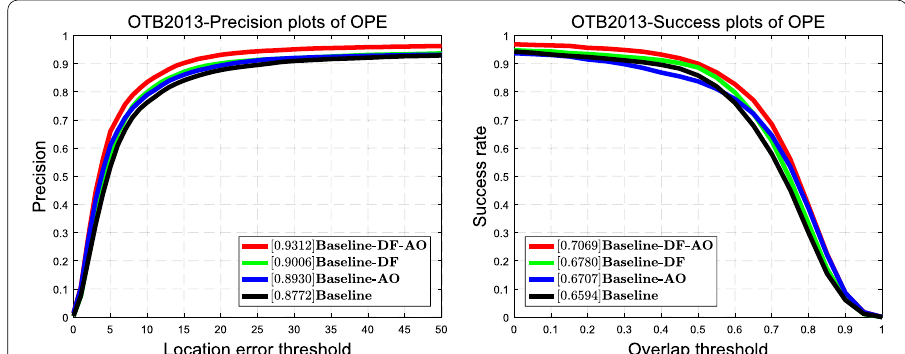
Fig. 11 Performance evaluation results of compared itself with different modules enabled on OTB2013 dataset